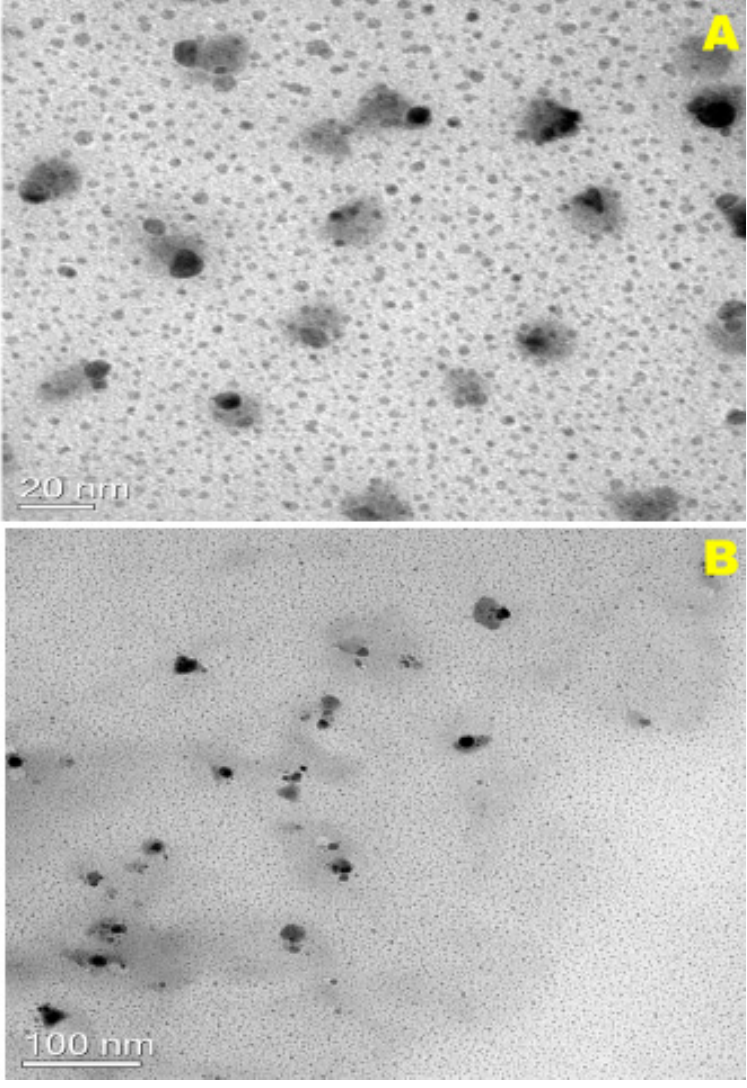
Figure 5. TEM micrographs (A) Turmeric and (B) BR (Benzoin resin) smudges.